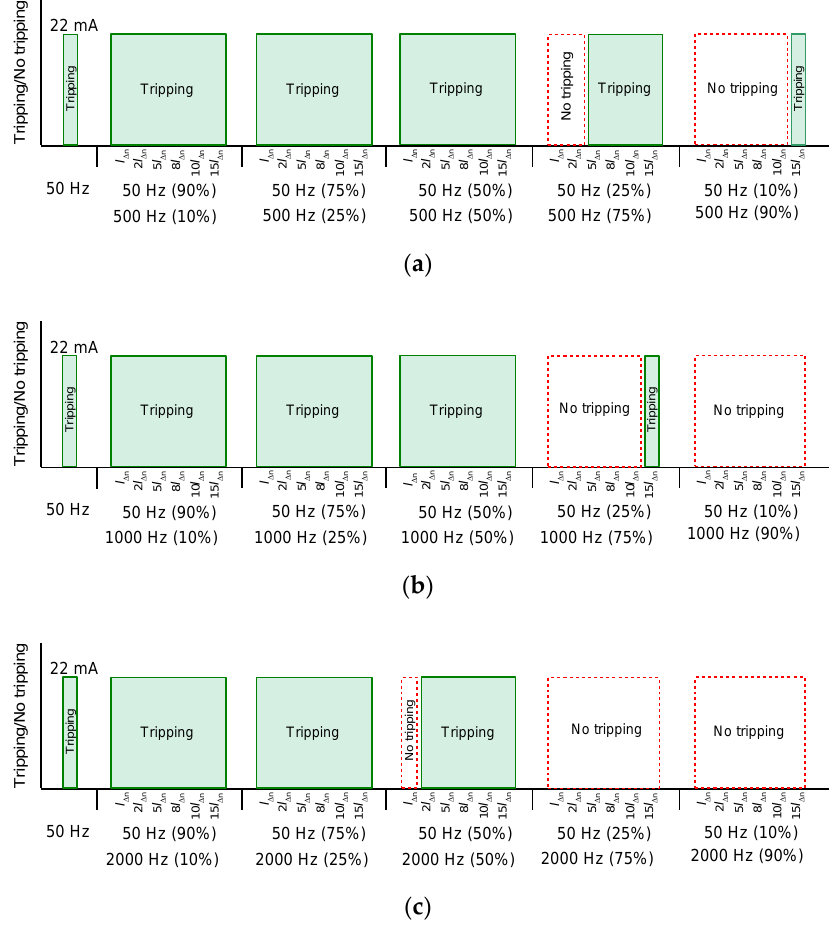
Figure 9. Tripping of the 30 mA AC-type RCD (no. RCD_1AC—symbol defined in Table 2) for waveform composed of the fundamental frequency (50 Hz) and high-frequency component: ( a ) 500 Hz; ( b ) 1000 Hz; ( c ) 2000 Hz. Values in brackets indicate the content of the particular component; 22 mA—real tripping current for a pure sinusoidal signal of 50 Hz.